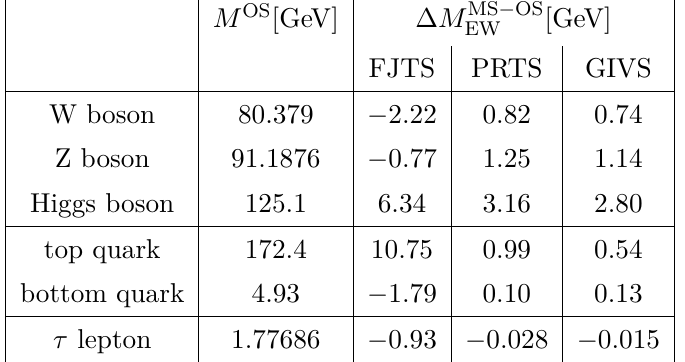
Table 1 . On-shell masses M OS of the heaviest SM particles and differences ∆ M MS − OS the MS mass M ( µ = M OS ) and M OS induced by NLO EW corrections using the FJTS, PRTS, or